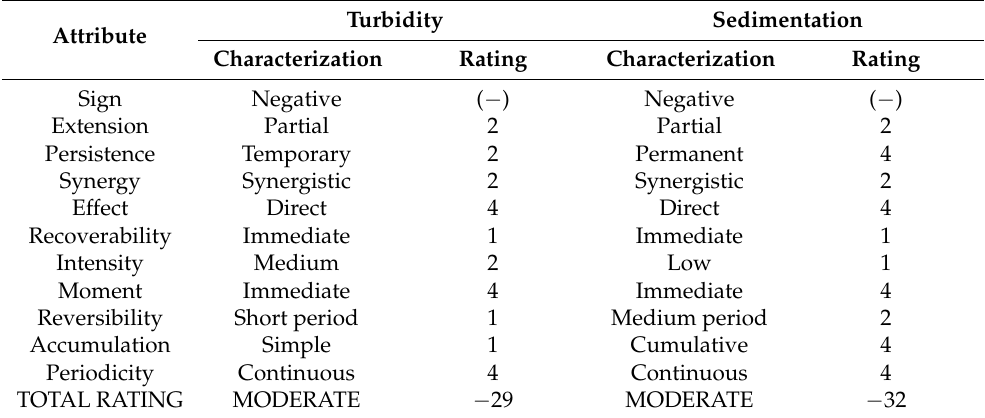
Table 2. Overall assessment of the impact on turbidity and sedimentation during the construction phase. Turbidity Sedimentation Attribute Characterization Rating Characterization